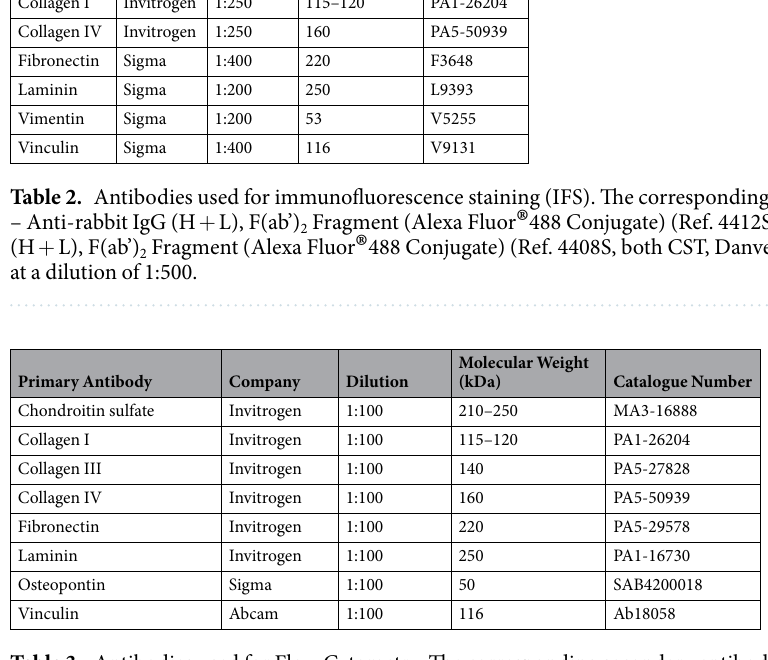
Table 3. Antibodies used for Flow Cytometry. The corresponding secondary antibodies – Anti-rabbit IgG (H + L), F(ab’) 2 Fragment (Alexa Fluor ® 488 Conjugate) (Ref. 4412S) and Anti-mouse IgG (H + L), F(ab’) 2 Fragment (Alexa Fluor ® 488 Conjugate) (Ref. 4408S, both CST) – were used at a dilution of